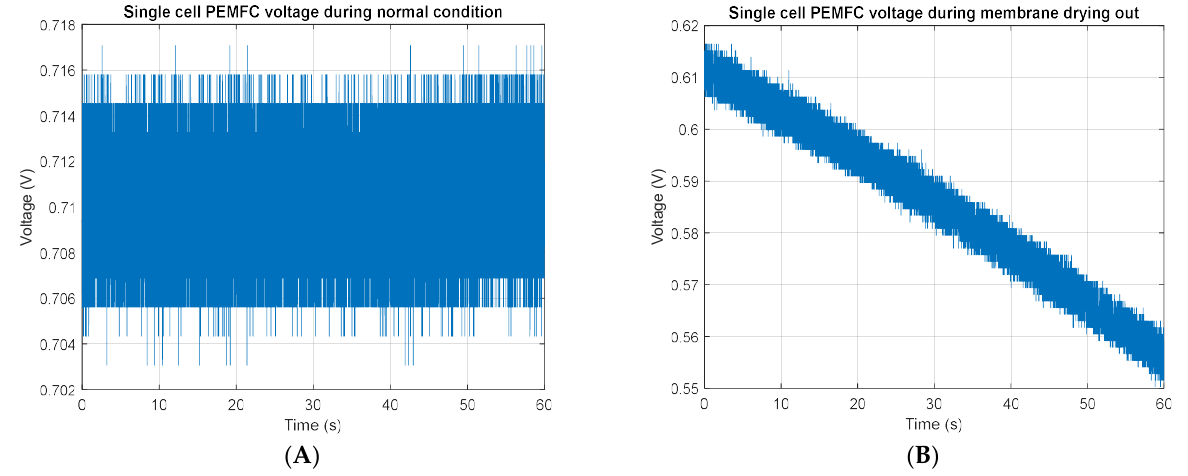
Figure 15. Voltage measurement for normal and drying-out conditions. The first ( A ) graph is the fuel cell voltage measurement under normal condition whereas ( B ) is for the membrane drying out condition.